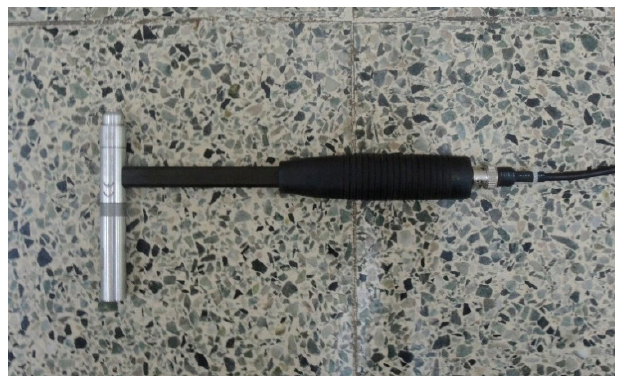
Figure 7. The AE sensor mounted with the magnetic hold down and vacuum grease couplant.